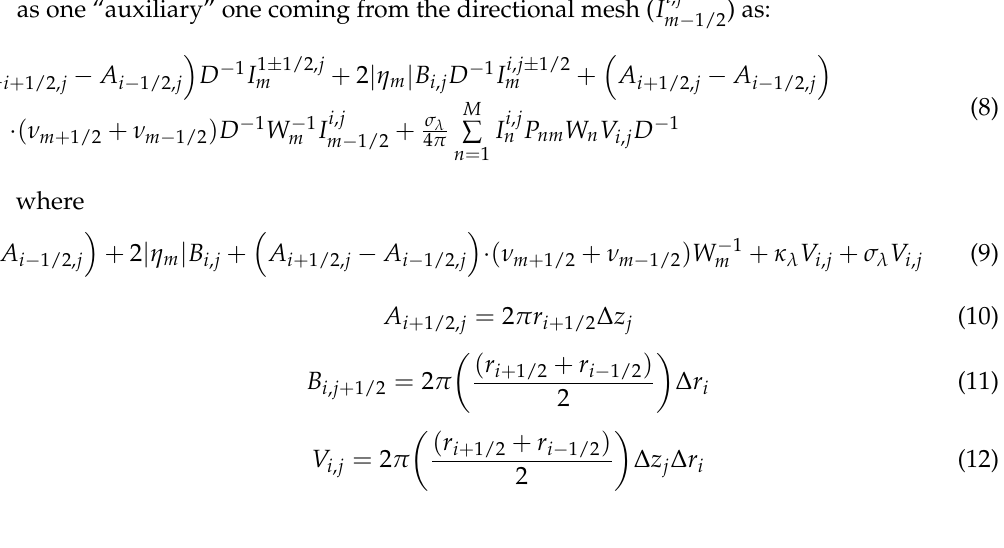
Once the optical properties of the catalyst(s) have been obtained, we proceed to evaluate the radiation field inside the photoreactor. The DOM tool was used to trans- form the integro-differential Equation (4) into a system of algebraic equations that can be solved numerically. Our reactor configuration demands the use of a cylindrical two- dimensional ( r − z variables), two-directional ( θ − φ variables) model of the photoreactor radiation field (Figure 11B,C). The net radiation intensity at each r − z point of the reactor is now represented using a discretized spatial mesh having two angular-related coordi- nates µ = cos ( θ ) ; η = cos ( φ ) . Figure 11C displays µ ; η unitary, basal projection(s) in a quadrant (quadrant I) of the space around an r − z point calculated using the so-called S 16 method [41]. For the two-dimensional representation of the space, the calculation of the intensity at each point of the reactor requires dividing the space into four quadrants as depicted in Figure 11D and the measurement of the incident light intensity at the boundary (liquid surface) using actinometry and potassium ferric oxalate [41]. Boundary intensity for UV illumination takes a value of 1.10 × 10 − 8 Einstein cm − 2 s − 1 sr − 1 . Using Duderstadt and Martin’s procedure [42] and numerical tools developed in previous contributions [41], the finite difference (DOM) was derived directly from the radiation balance for each mesh cell (Figure 11D). In this way, the central intensity at each cell ( I i , j m ) can be calculated from ± 1/2, j the previous ones starting from the appropriate boundary values ( I 1